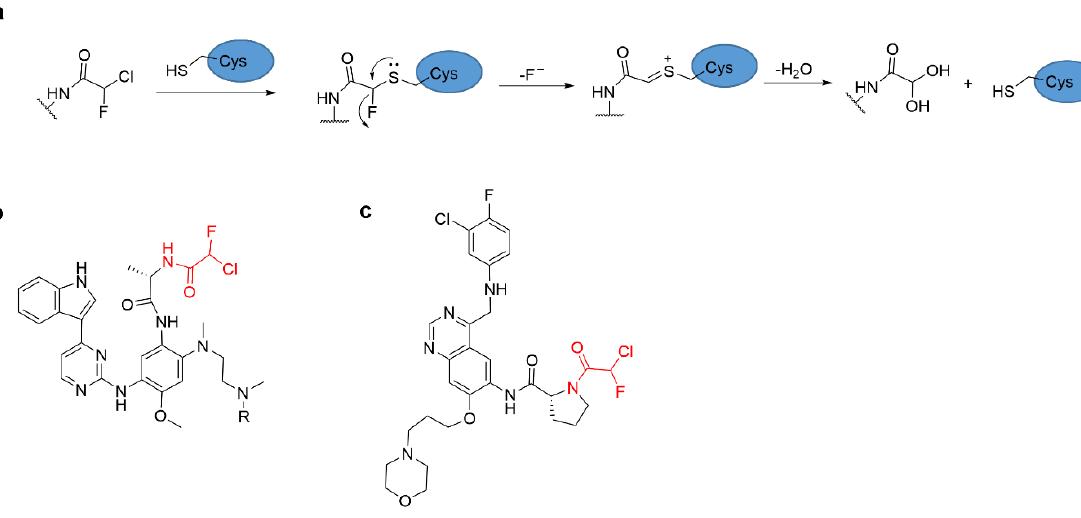
Figure 10. ( a ) The mechanism of the reaction of CFA with cysteine. Chemical structures of ( b ) α‐ chlorofluoroacetamide ‐ based covalent inhibitor of EGFR ( c ) α‐ chlorofluoroacetamide ‐ based covalent inhibitor NS ‐ 062.